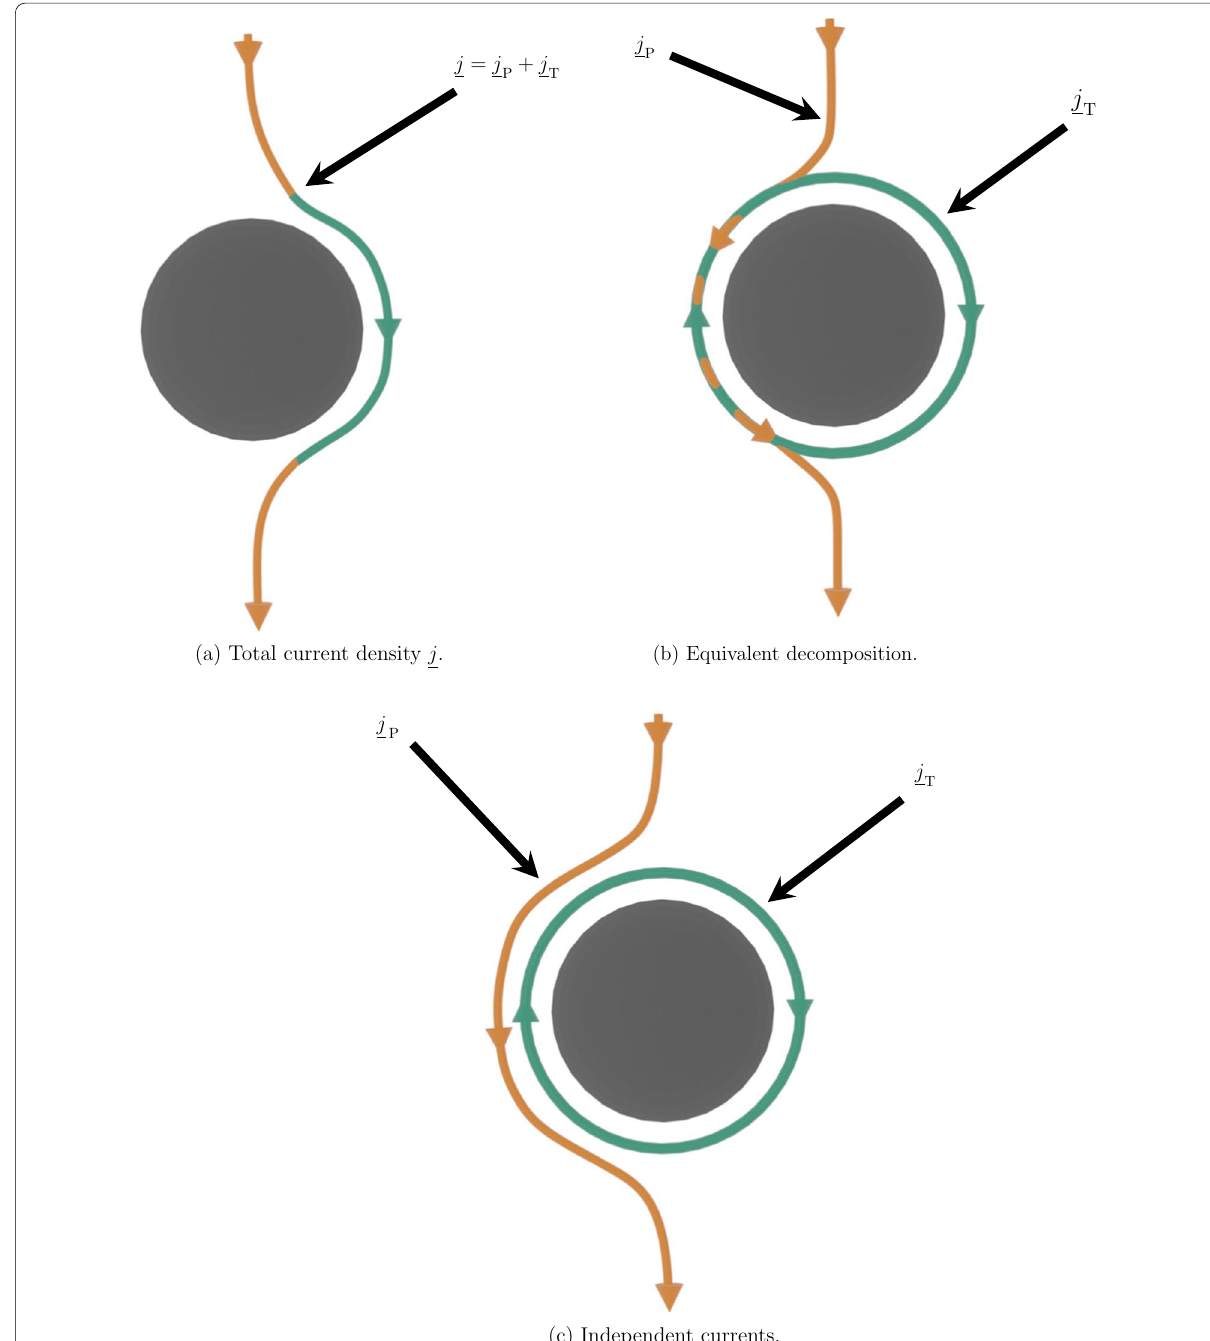
Fig. 6 Superposition of poloidal (orange) and toroidal (green) currents. A vanishing current density j = 0 on the left side of the grey sphere ( a ) can equivalently be described as a superposition of non‑vanishing poloidal and toroidal currents, so that j flow independently of each other in a certain spatial distance ( c